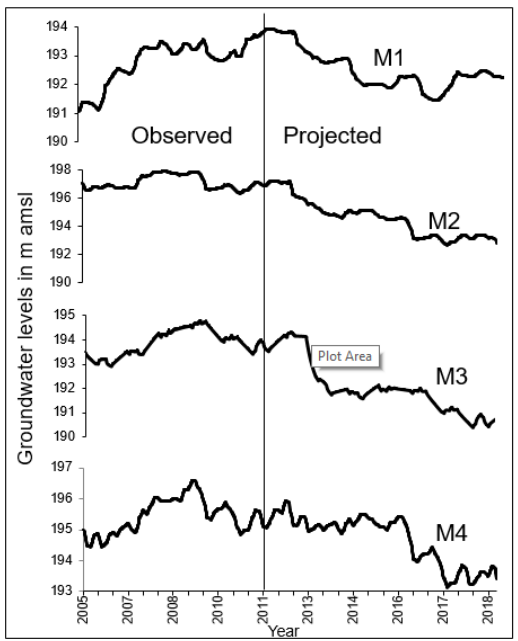
Figure 7. Observed and projected groundwater levels in the Muktsar district.